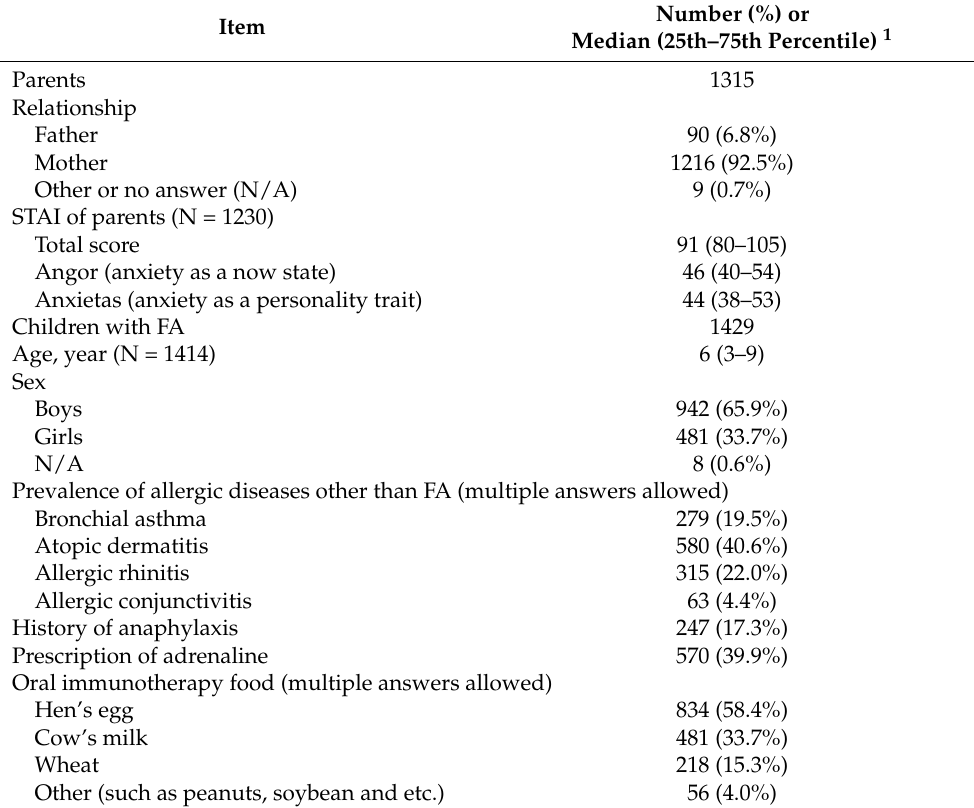
Table 1. Background information of parents and